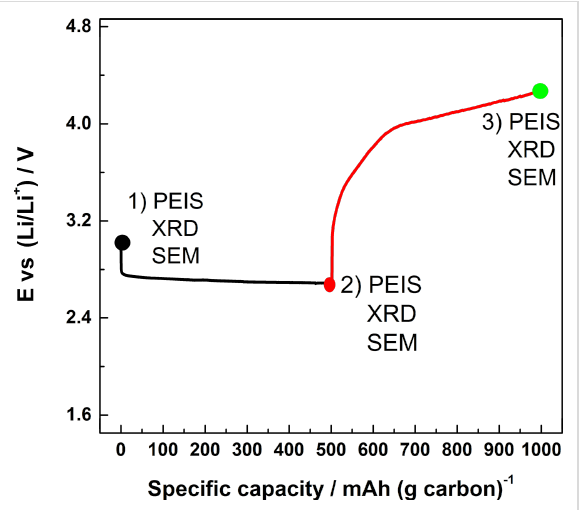
Figure 1: First galvanostatic discharge/charge curve of a typical Li–O 2 battery consisting of a carbon-based cathode, lithium metal anode and LiTFSI/tetraglyme as electrolyte.